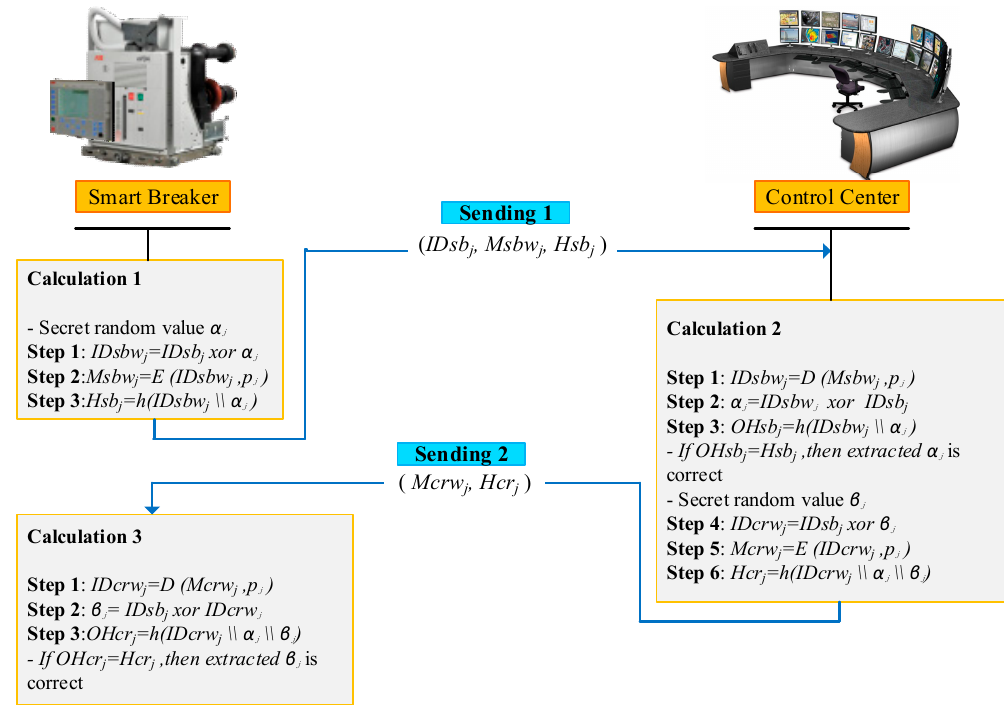
Figure 5. Authentication Scheme SB to CC.